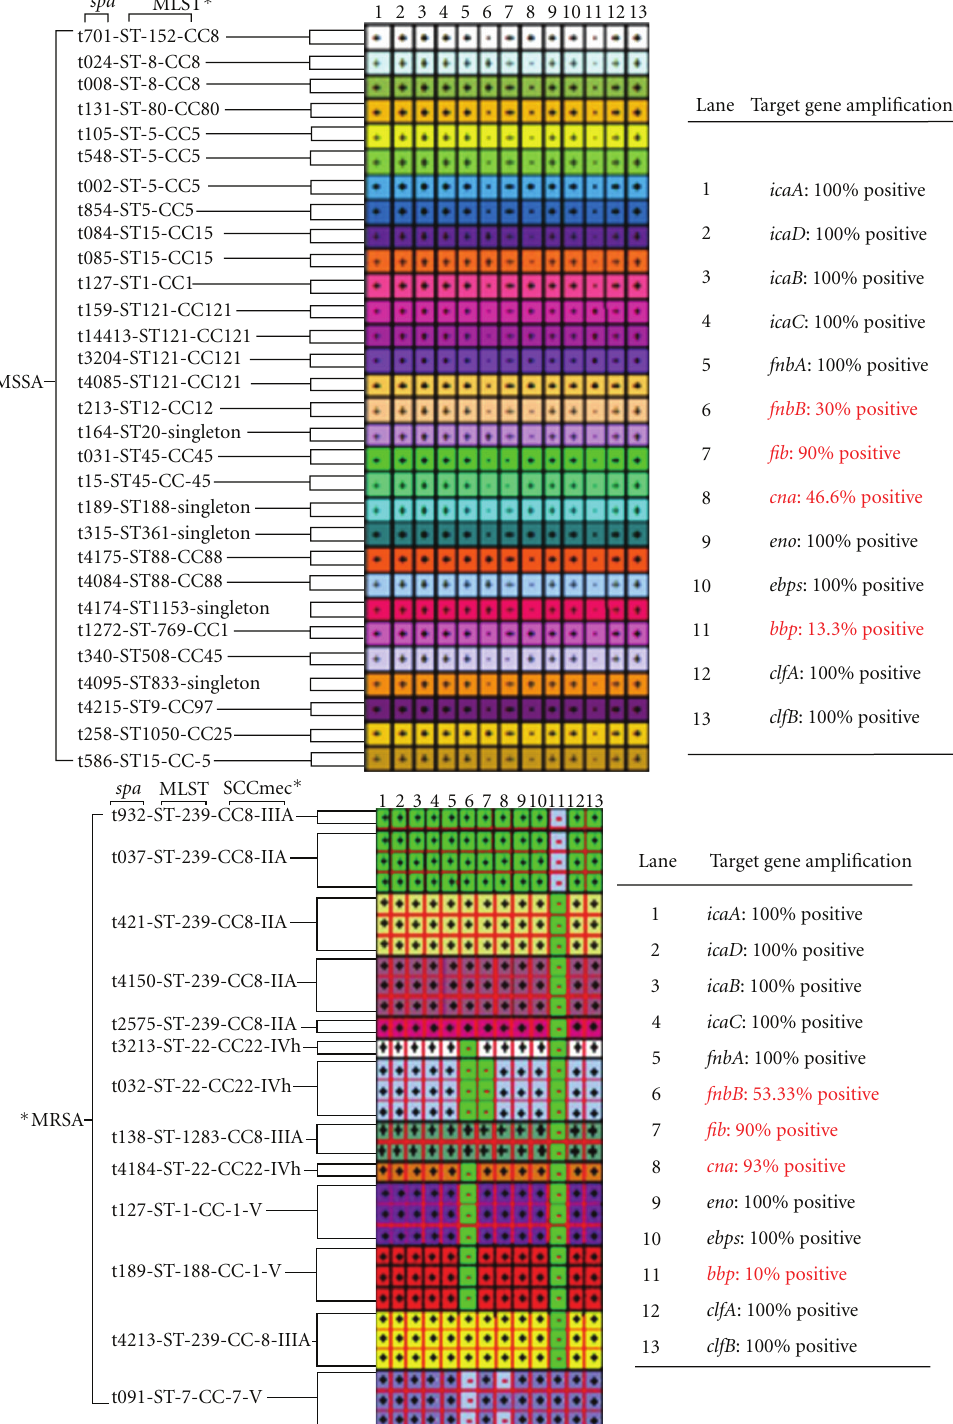
Figure 2: Comparing the di ff erences in the molecular determination of the microbial surface components recognizing adhesive matrix molecules (MSCRAMMs) and biofilm genes between MSSA and MRSA isolates. bbp : sialoprotein binding protein, fnbB : fibronectin binding protein B, and cna : collagen binding protein. The intercellular adhesion biofilm genes: icaADBC , fibronectin binding protein A ( fnbA), laminin binding protein ( eno), elastin binding protein (ebpS), and clumping factors A and B (clfA and B), their distribution did not di ff er between clones associated with MSSA and those with MRSA. Spa refers to Staphylococcal surface protein A. MLST ∗ refers to multilocus sequence typing. SCC mec ∗ refers to staphylococcal cassette chromosome. MSSA ∗ refers to methicillin-senstive Staphylococcus aureus. MRSA ∗ refers to methicillin-resistant Staphylococcus